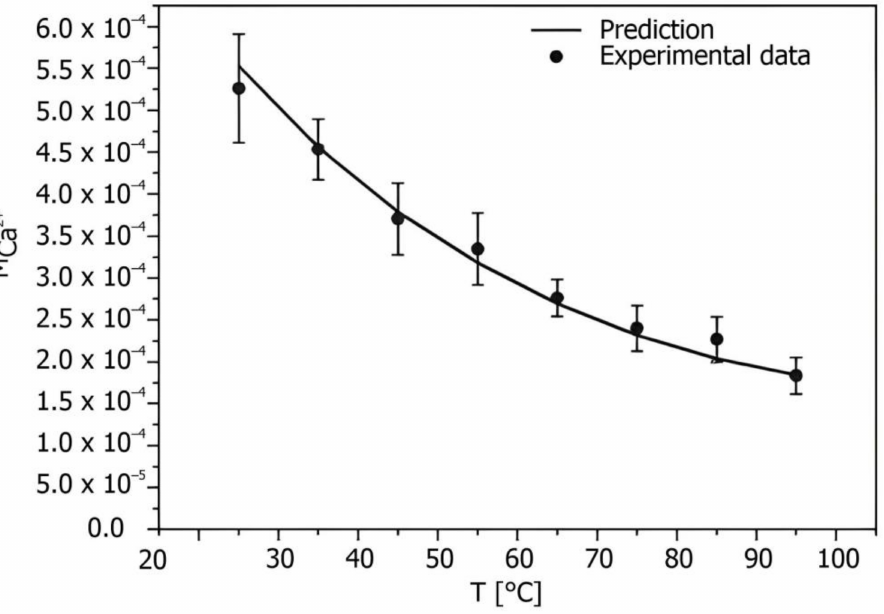
Figure 1. Influence of the temperature on CaCO 3 solubility (P = 1 bar), adapted from